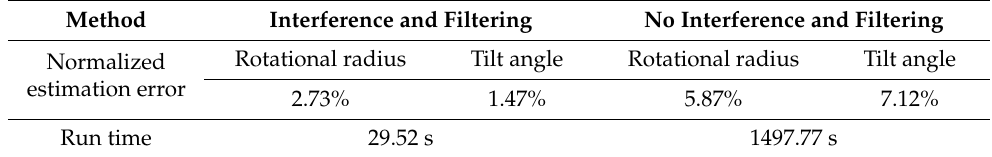
Table 4. Comparison of normalized estimation error and running time of the two methods.